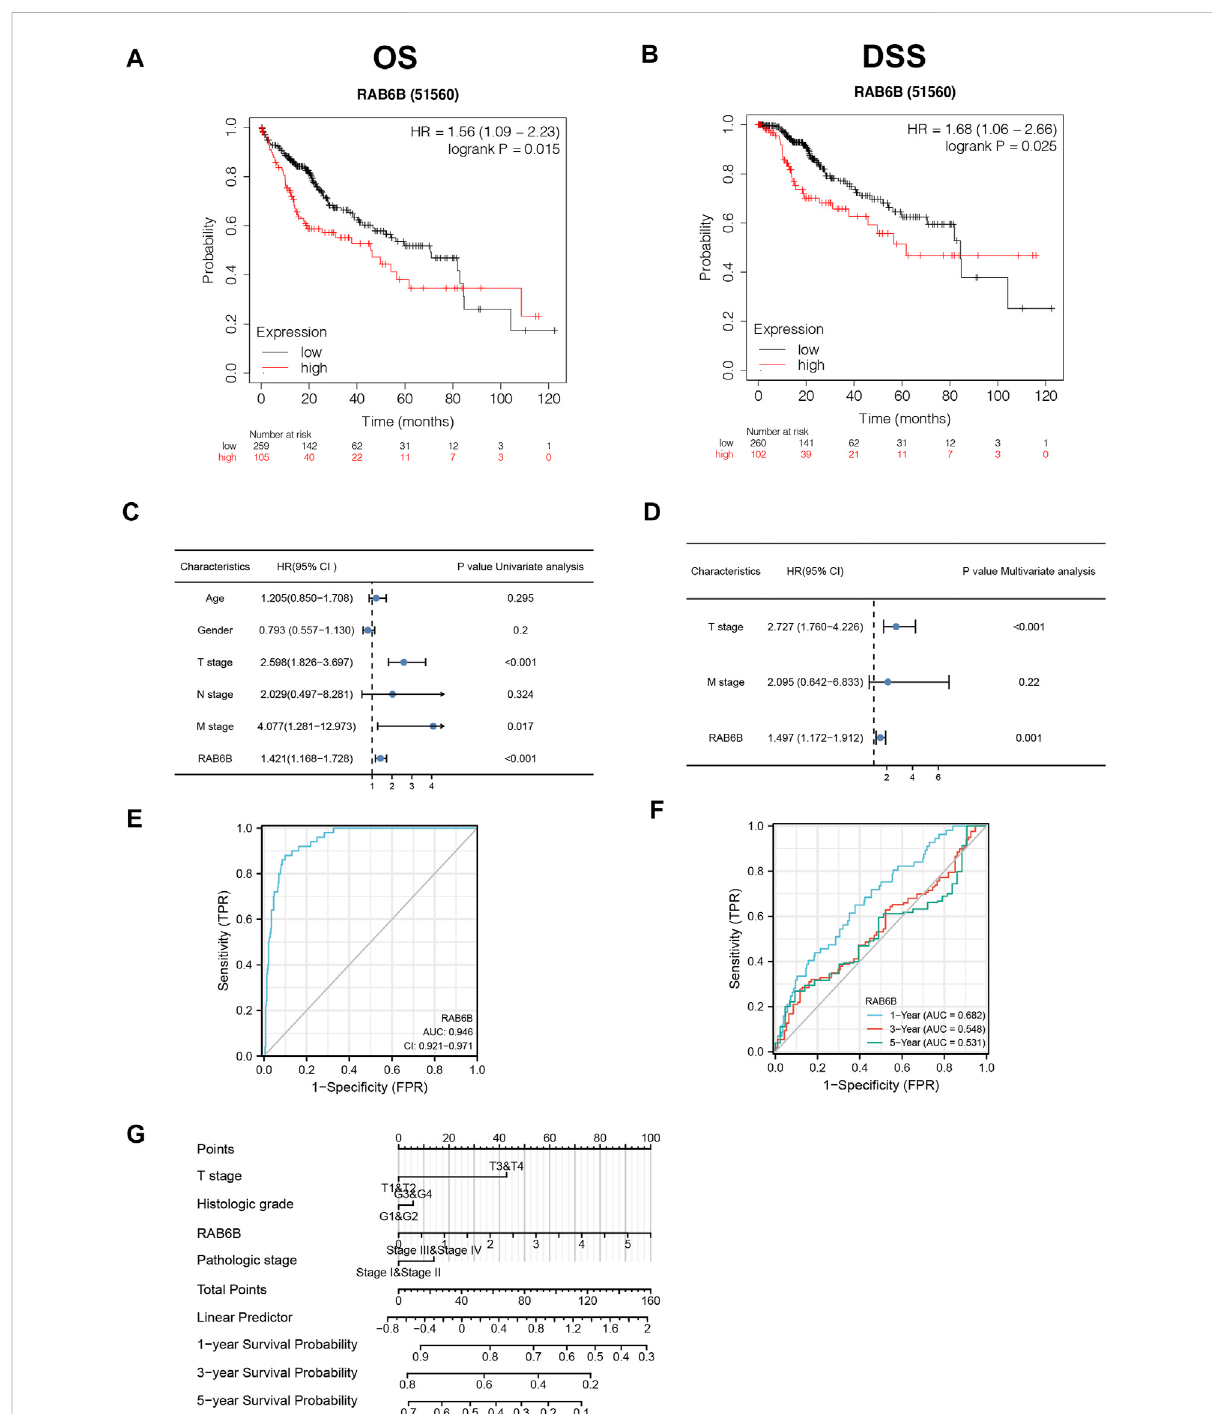
FIGURE 2 The prognostic and diagnostic value of RAB6B in patients with HCC. (A,B) Kaplan – Meier survival analysis showed that HCC patients with high RAB6B expression exhibited a shorter overall survival (OS) (A) and disease speci fi c survival (DSS) (B) than those with low RAB6B expression. (C) Univariate COX analysis revealed that T stage, M stage, and RAB6B expression were signi fi cant factors affecting the survival rate of HCC patients. (D) Multivariate COX analysis showed that T stage and RAB6B expressionwereindependent prognostic factors inHCC patients. (E) ROC curve was used to evaluate the diagnostic value of high RAB6B level for HCC patients in TCGA. (F) Time-dependent survival ROC curve analysis was used to predict 1-, 3- , and 5-years survival rates. (G) Nomogram integrating clinicopathologic features and RAB6B level was constructed to predict prognostic probabilities at 1-, 3-, and 5-years in the TCGA